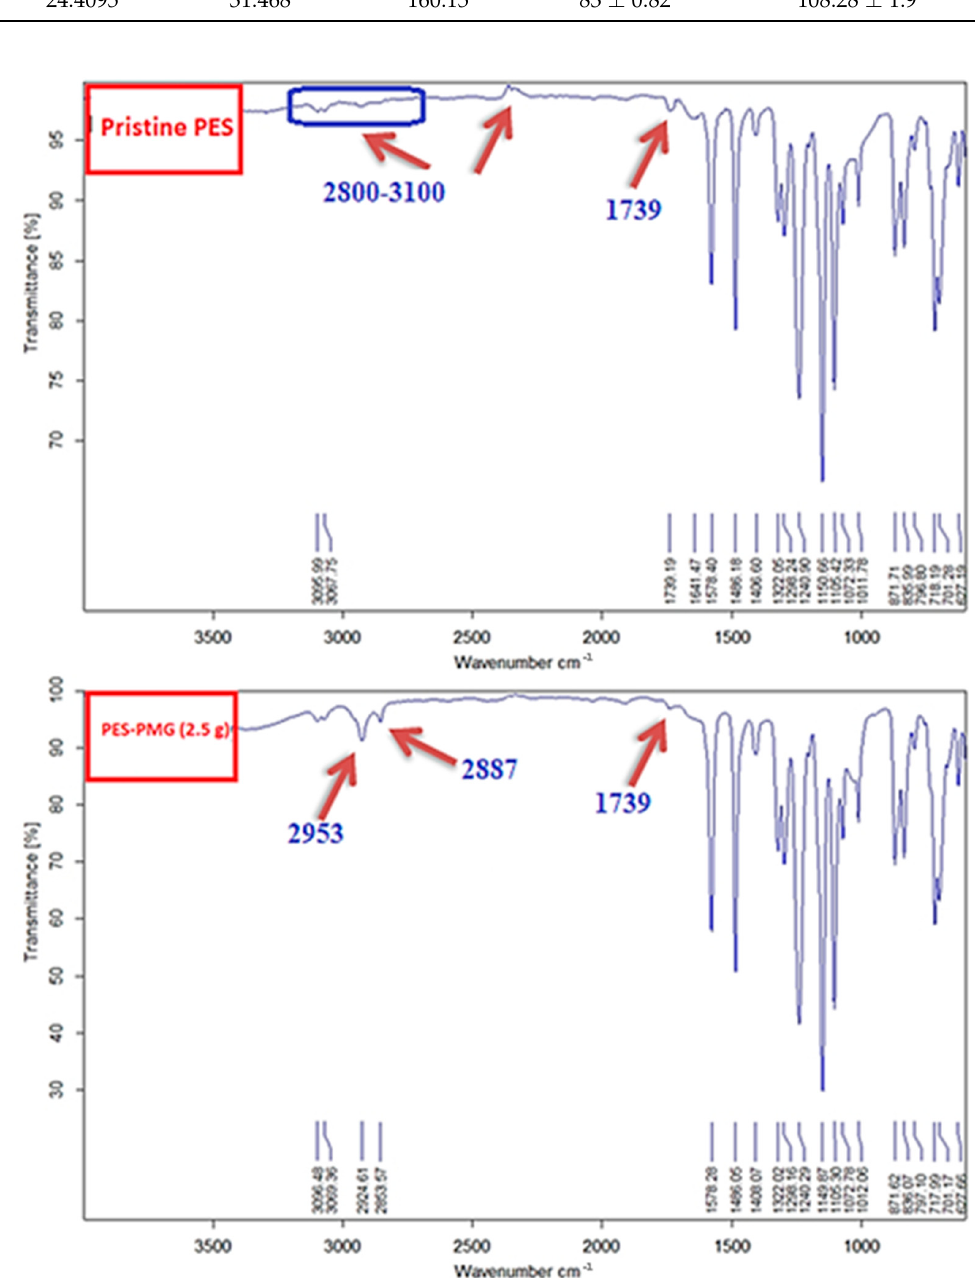
Figure 8. FT-IR spectra of pristine and 2.5 g PMG-modified mixed Figure 8. FT ‐ IR spectra of pristine and 2.5 g PMG ‐ modified mixed matrix.